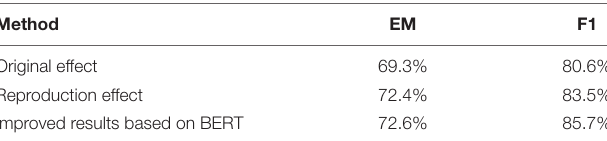
TABLE 2 | Comparative experimental results based on Bidirectional Encoder Representation from Transformers